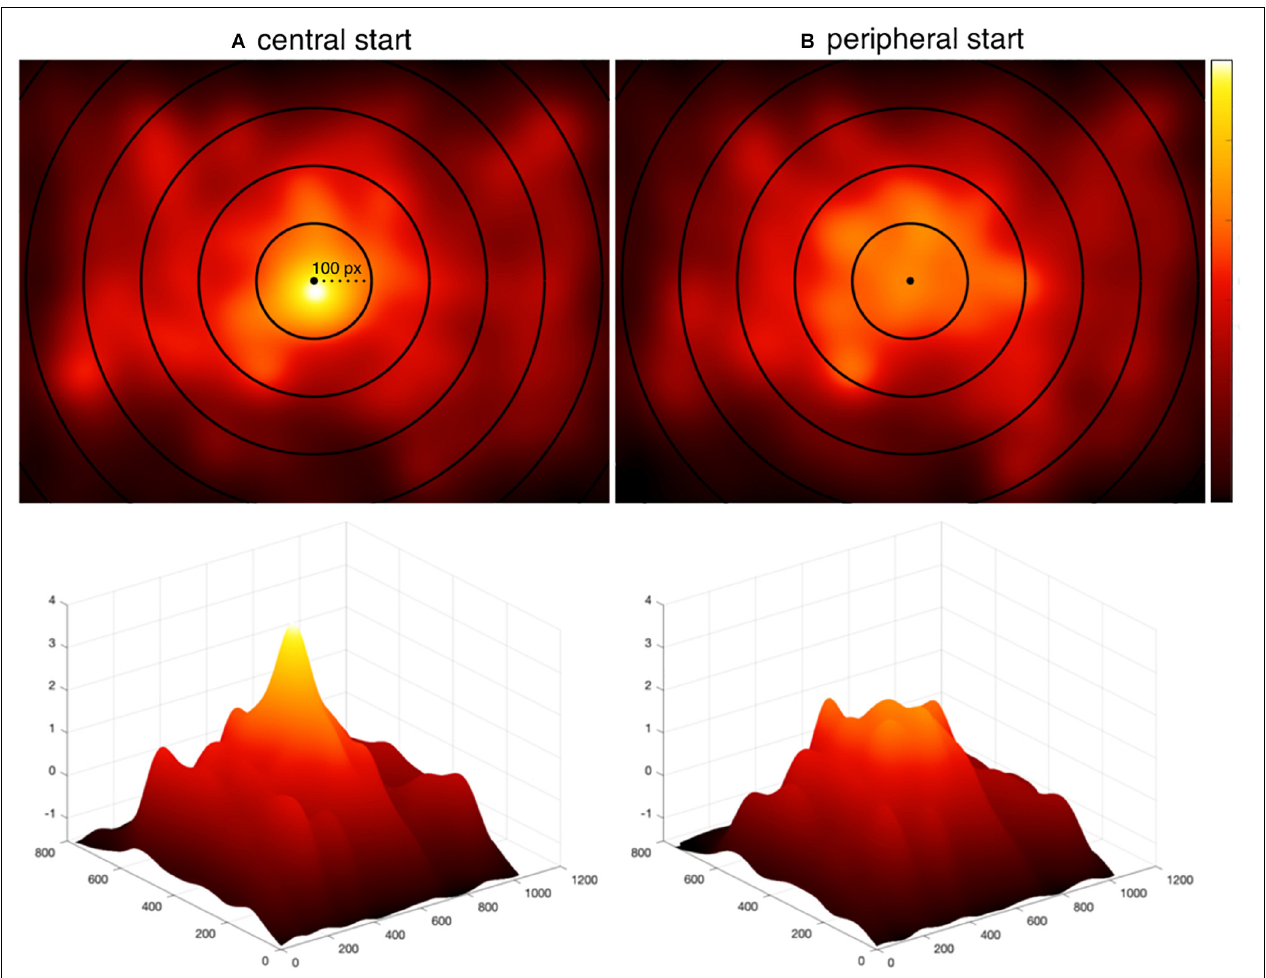
FIGURE 4 | Fixation distributions. The distribution of all fixations aggregated across participants and scenes (A) from Peacock et al. (2019b) using a centrally located fixation cross, and (B) from the current experiment using a peripherally located fixation cross with delayed trial start. Concentric circles are overlaid on each map to show the extent of central bias. The most inner circle has a radius of 100 pixels and each circle increments the radius by 100 pixels. The second row visualizes the same heat maps in three dimensions. Heat maps are z-normalized to a common scale with black representing no fixations and white representing the highest density of